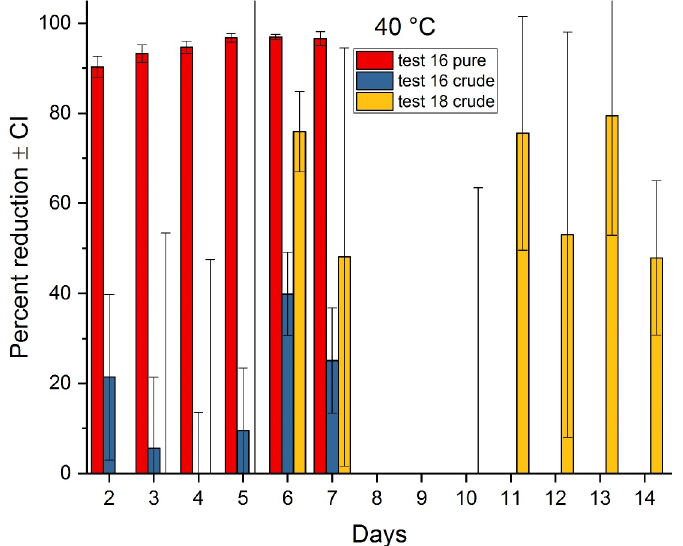
Fig 2. Attenuation of ricin at 40˚C air temperature on mild steel as a function of time. Test 16 evaluated elapsed times from 2–7 days; Test 18 evaluated exposure times of 3–14 days.